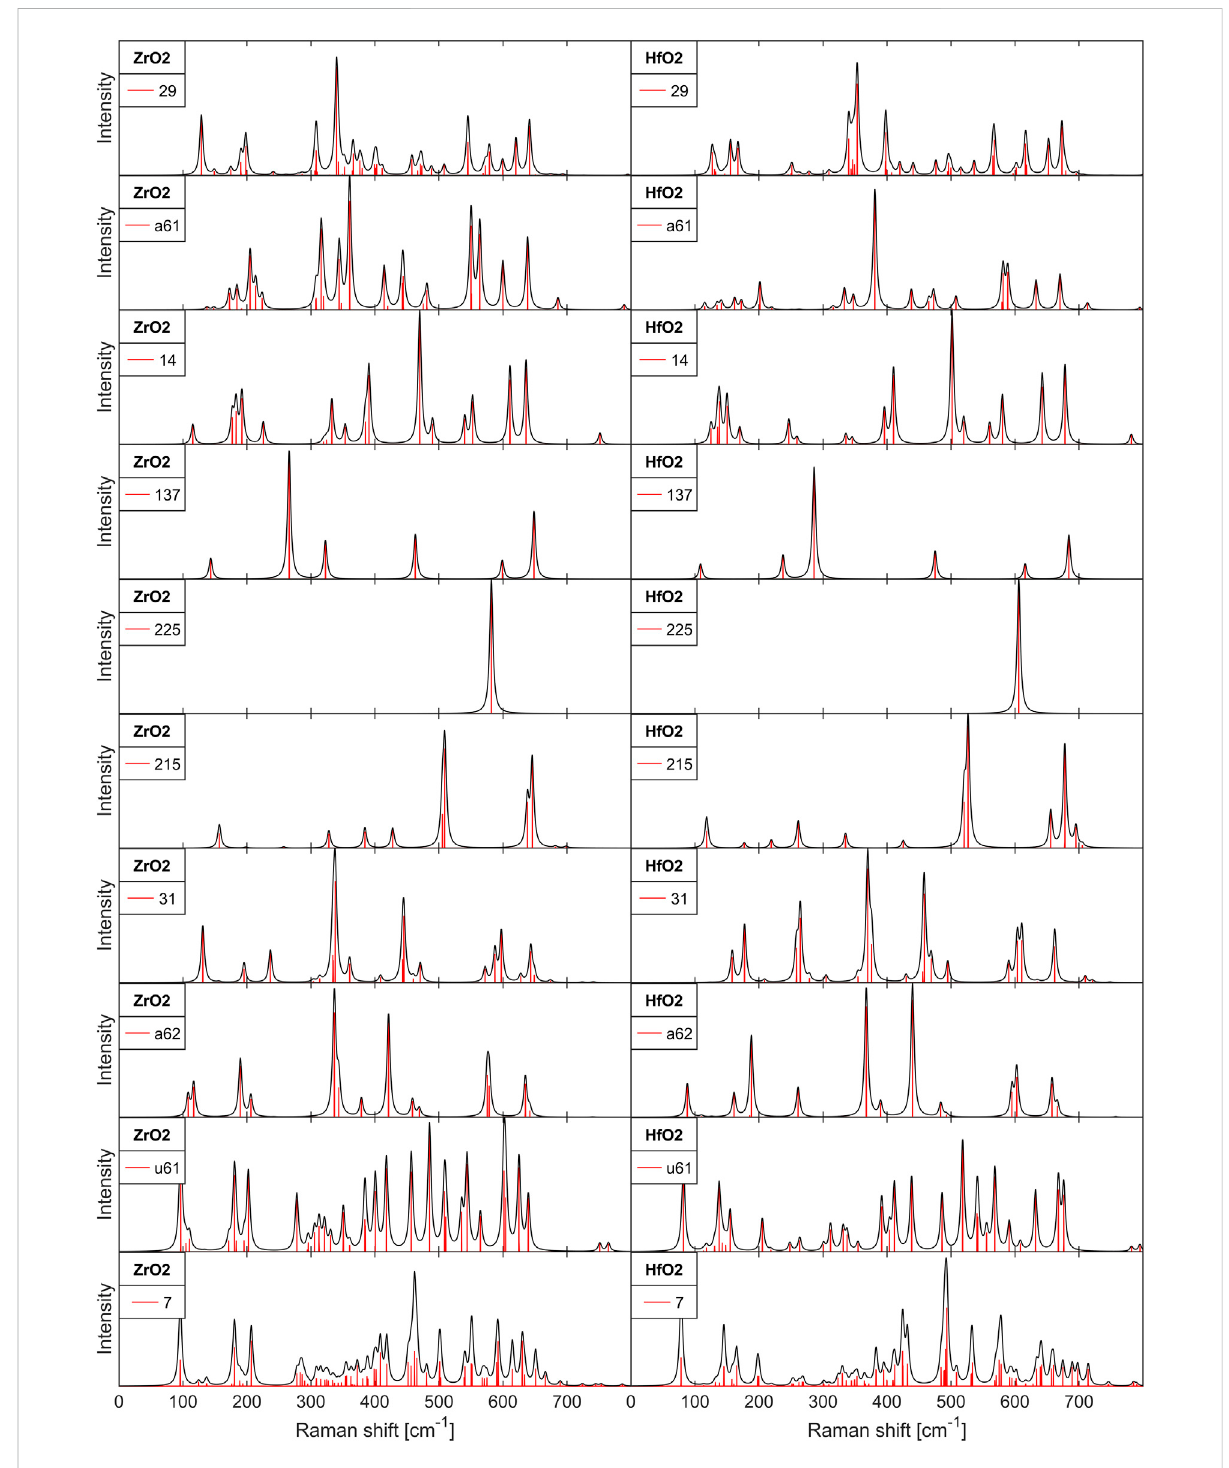
FIGURE 1 Raman intensity and Raman lines for undoped, polycrystalline ZrO 2 and HfO 2 fi